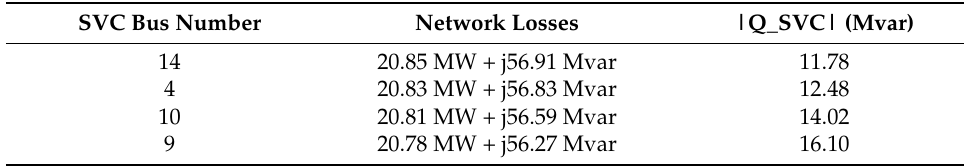
Figure 2. Total voltage drop in network Vn (for j = 1 and j = 2) after SVC installation at buses 14, 4, 10, and 9. Table 3. Network losses and reactive power injected by SVC, j =